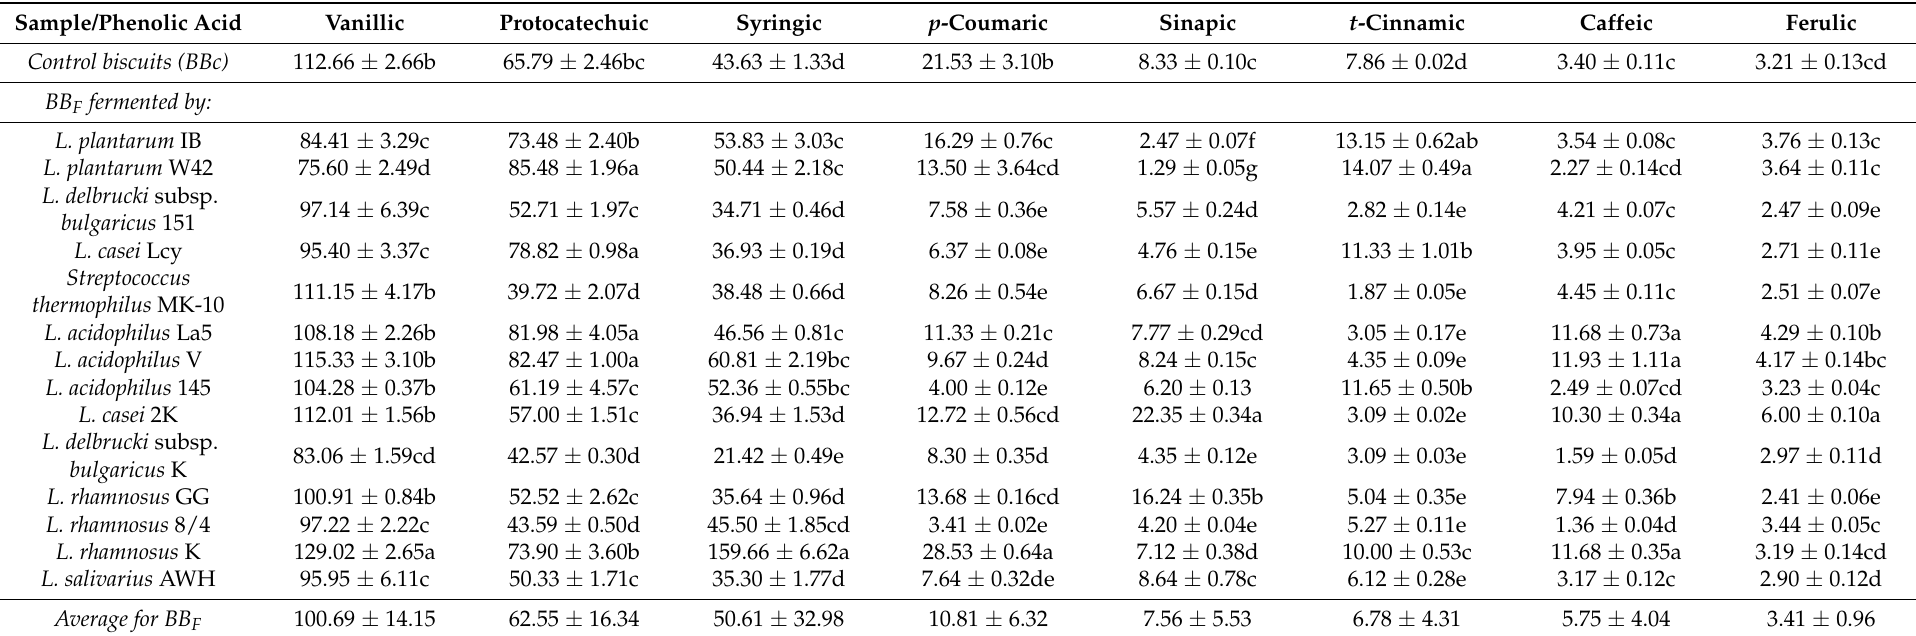
Table 1. The content of phenolic acids ( µ g/g DM) in buckwheat biscuits prepared from unfermented (BB C ) and fermented flours (BB F ) by selected lactic acid bacteria. Data are expressed as mean ± standard deviation ( n = 3). Means in each column followed by different letters are significantly different ( p < 0.05) based on the one-way analysis of variance